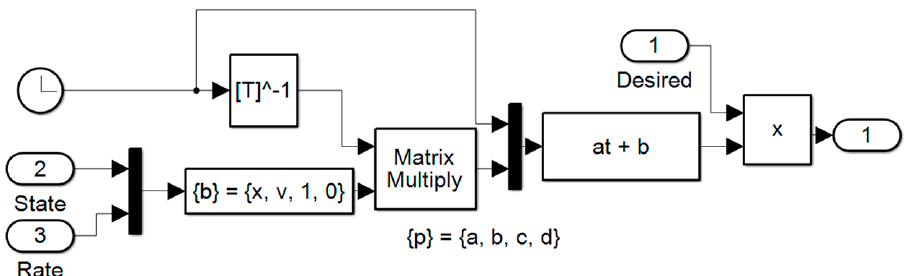
Figure A6. Closed-loop real-time optimal controller topology.